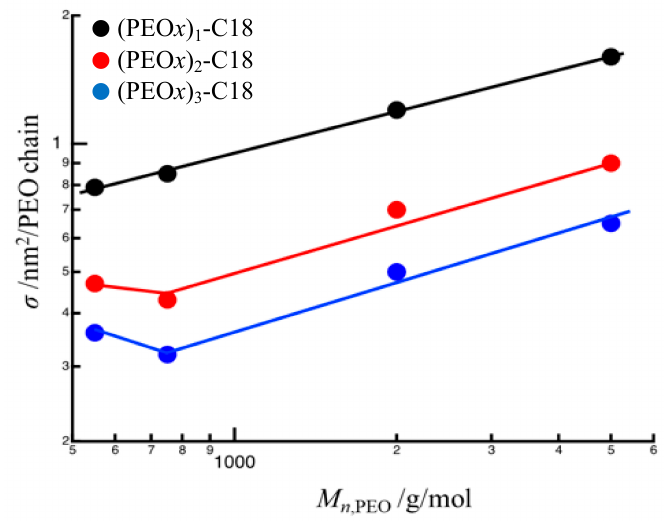
Figure 5. Occupied area of one PEO chain of (PEO x ) y -C18 on the interface of hydrophobic core and corona layer in (PEO x ) y -C18 micelles.